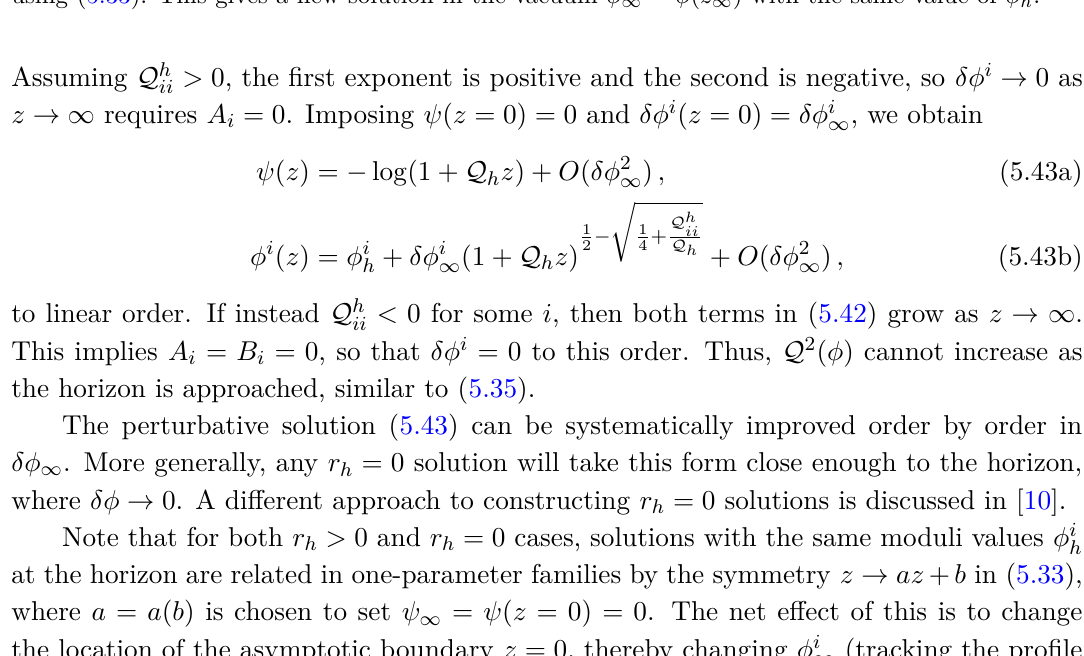
Figure 4. Solutions to the equations (5.32) come in one-parameter families related by the symme- try (5.33). Given one solution φ ( z ) in the vacuum φ (0) ∞ = φ (0) , pick any z ∞ < z h and set z ∞ = 0 using (5.33). This gives a new solution in the vacuum φ ∞ = φ ( z ∞ ) with the same value of φ h